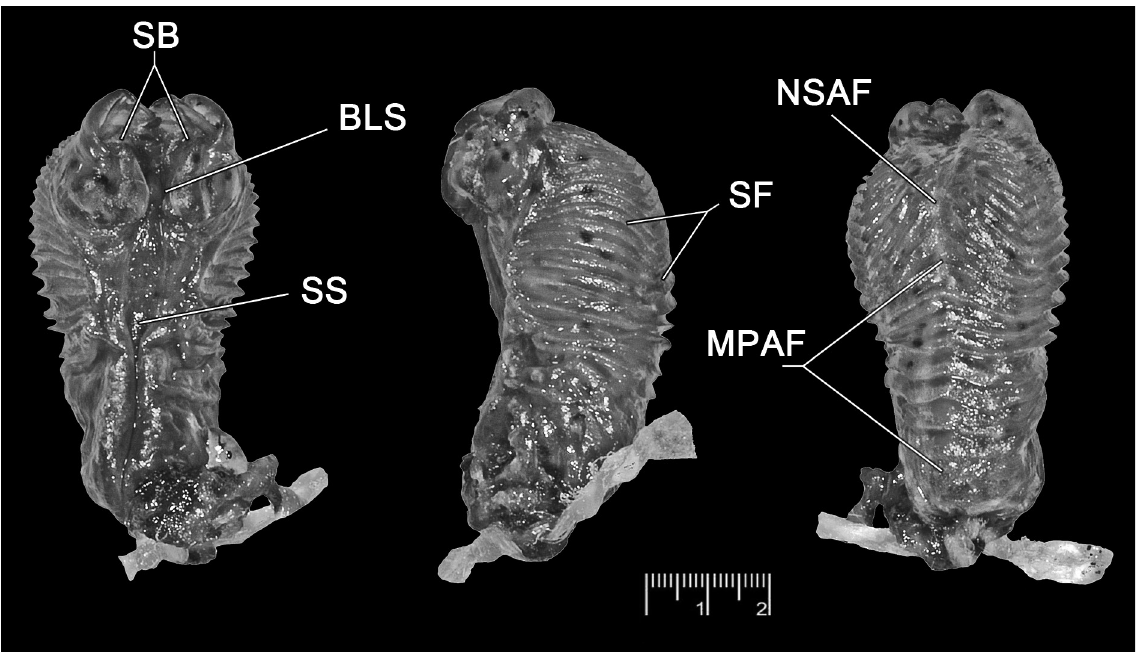
Fig. 5. Anadia mcdiarmidi sp. nov. The left fully everted—not maximally expanded—hemipenis of the holotype (IRSNB 2677). Left: sulcate side. Centre: lateral view, turned with sulcate side facing left. Right: asulcate side. BLS = fleshy bumplike structure; MPAF = medioproximal asulcate flounces; NSAF = median nude space of the asulcate face; SB = sulcus branches; SF = spinulate flounces; SS = sulcus spermaticus. Scale line = 2 mm. Although staining of the spinules by Alizarin Red is well visible under the microscope, the structures are not clearly observable in the figure. Photographs by Philippe J.R.